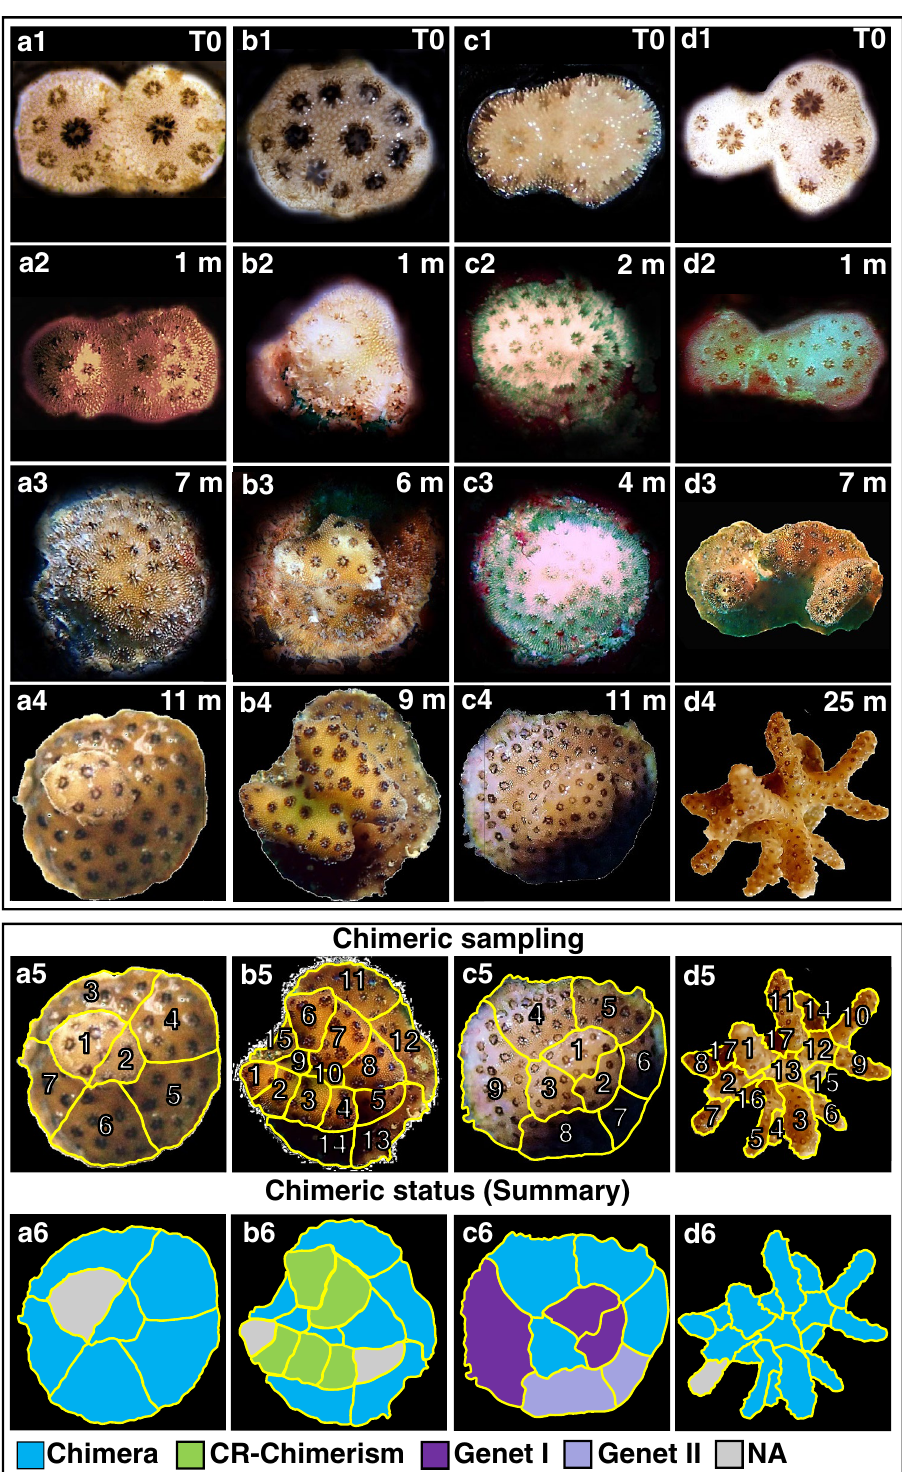
Figure 1. Chimerism and its detection in the coral Stylophora pistillata . Three bi-chimeras Chimera_33 ( a1 – 4 ), Chimera_40 ( b1 – 4 ), and Chimera_82 ( c1 – 4 ) and a three-partner chimera, Chimera_43 ( d1 – 4 ) are